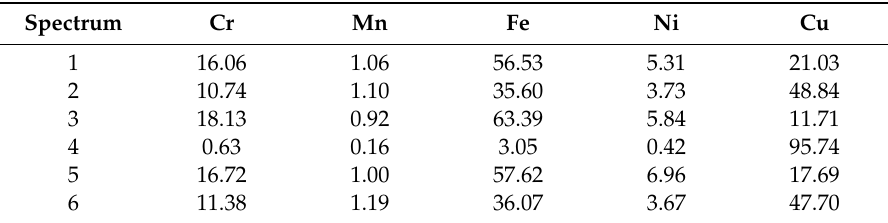
Table 7. EDS point analysis in local sites of weld metal (in at.